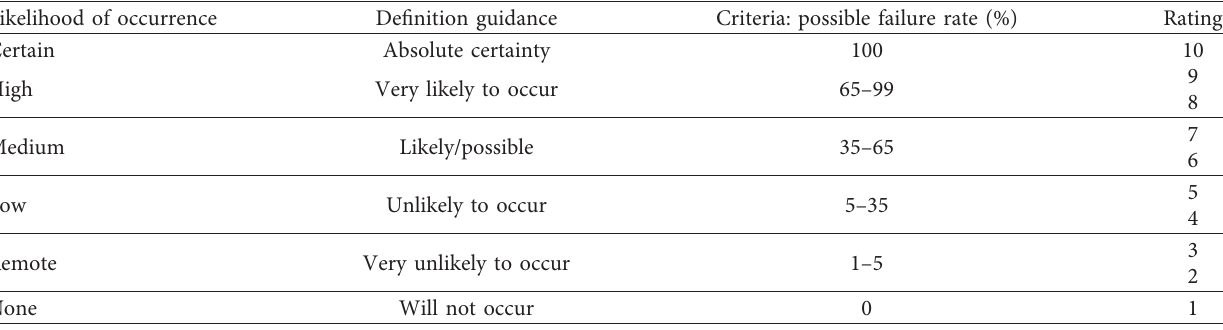
Table 2: Likelihood of occurrence.